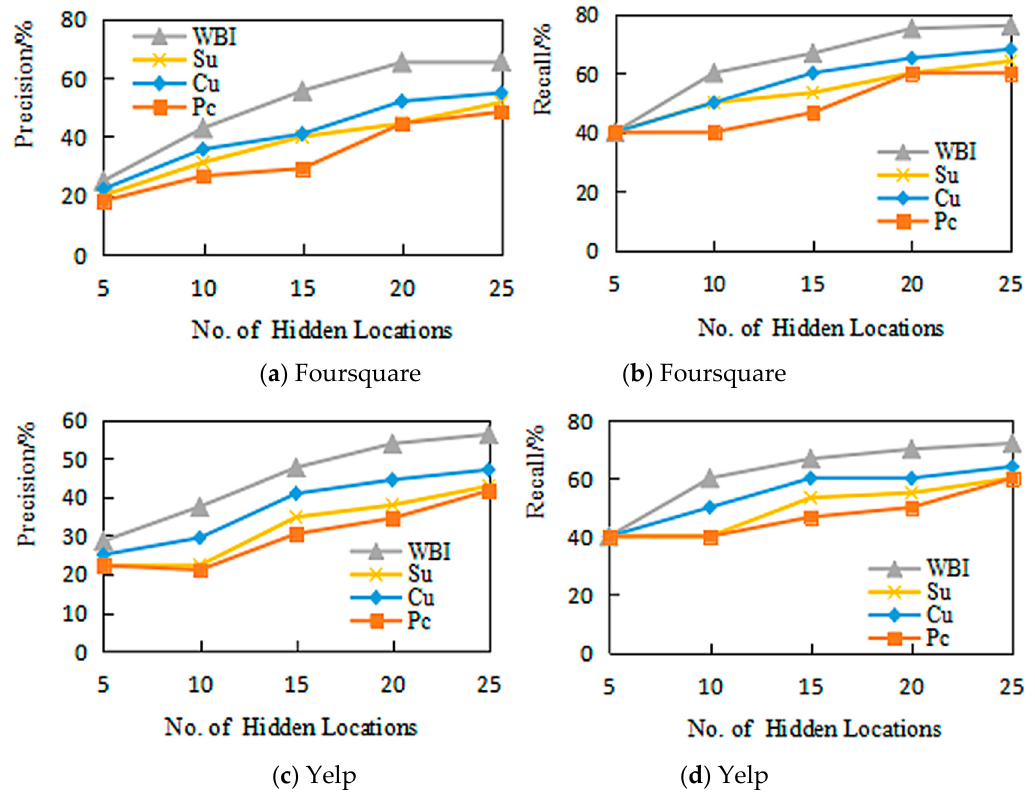
Figure 3. Prediction accuracy WBI with different weights.